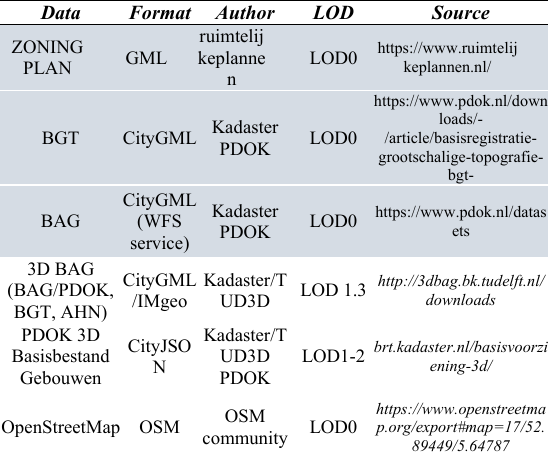
Table 1. Available datasets of the case study. Highlighted the dataset analysed for the present research.